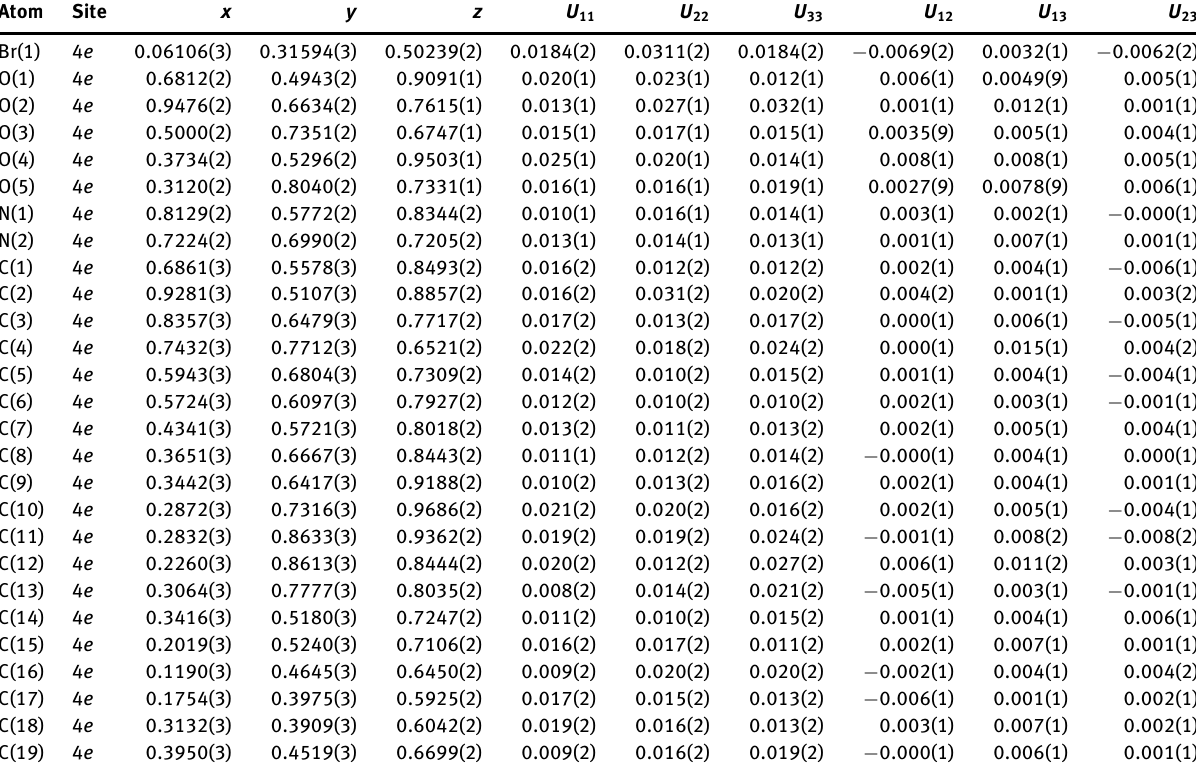
Table 3: Fractional coordinates and atomic displacement parameters (Å 2